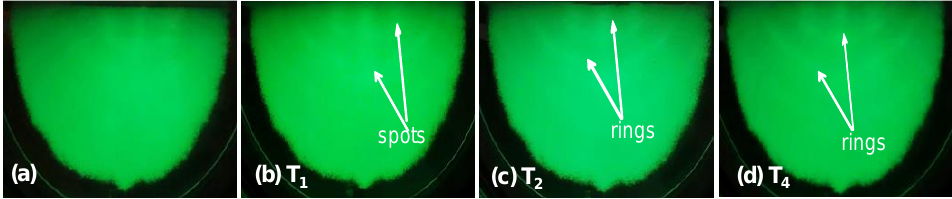
Figure 2. RHEED patterns: ( a ) Ni/SiO 2 /Si substrate after thermal cleaning, ( b ) T 1 (700/1200 °C), ( c ) T 2 (700/1300 °C), and ( d ) T 4 (800/1300 °C).